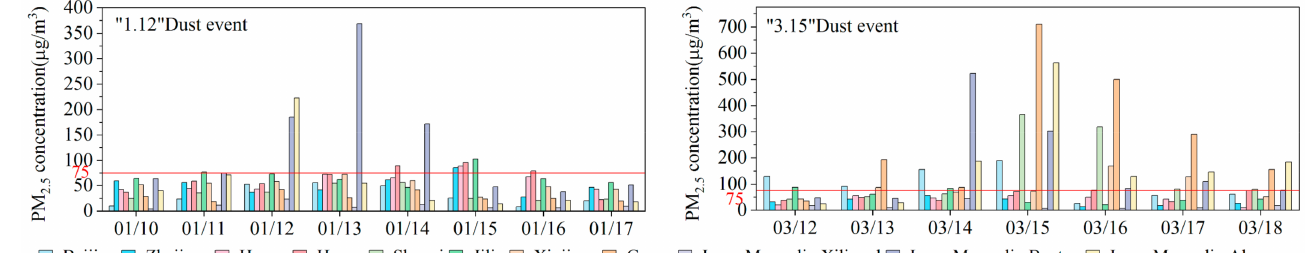
Figure 9. Daily average PM 2.5 values at ground stations during the 1.12 and 3.15 events.